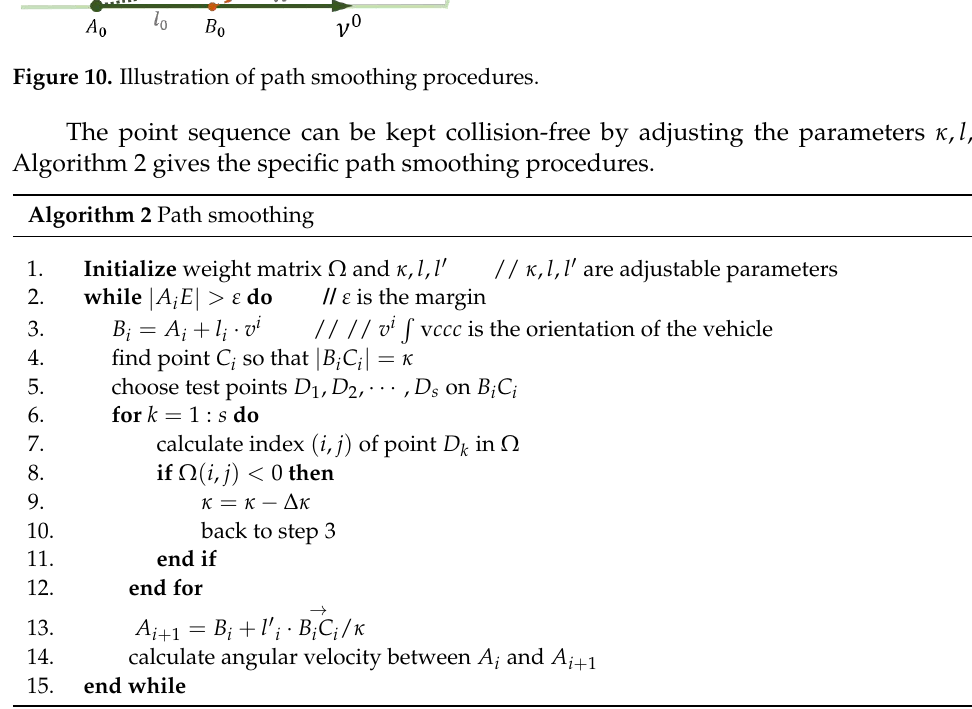
Figure 12. Illustration of the generated smooth, collision-free paths.